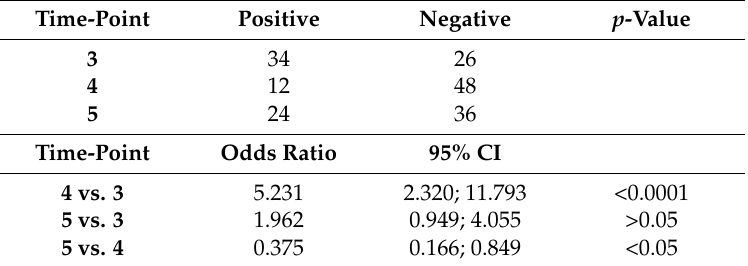
Figure 1. Means of the rearing periods at the respective sampling time-point. Table 5. qPCR positive and negative samples depending on the tested time-point: It shows the qPCR results of three rearing periods indicating significant differences of time-point 4 compared with time-points 3 and 5.